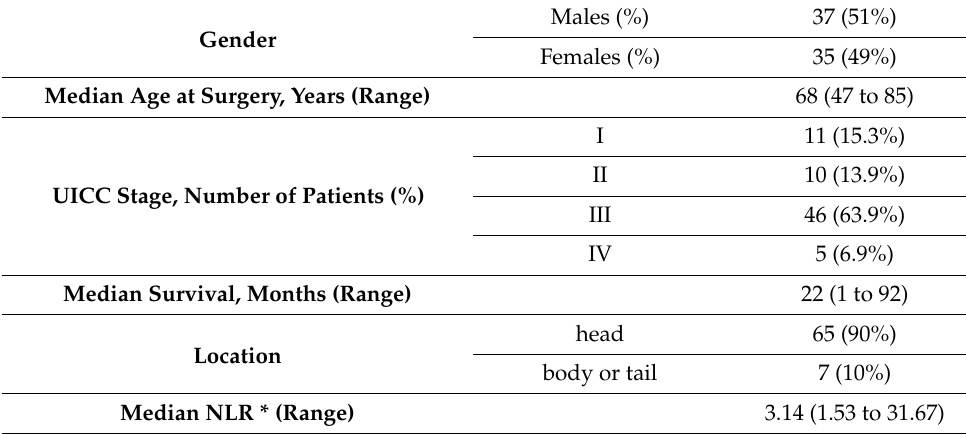
Table 1. Clinical data on pancreatic ductal adenocarcinoma (PDAC) patient cohort used in this study ( n = 72); abbreviations used: *: NLR: neutrophil-to-lymphocyte ratio; UICC: Union for International Cancer